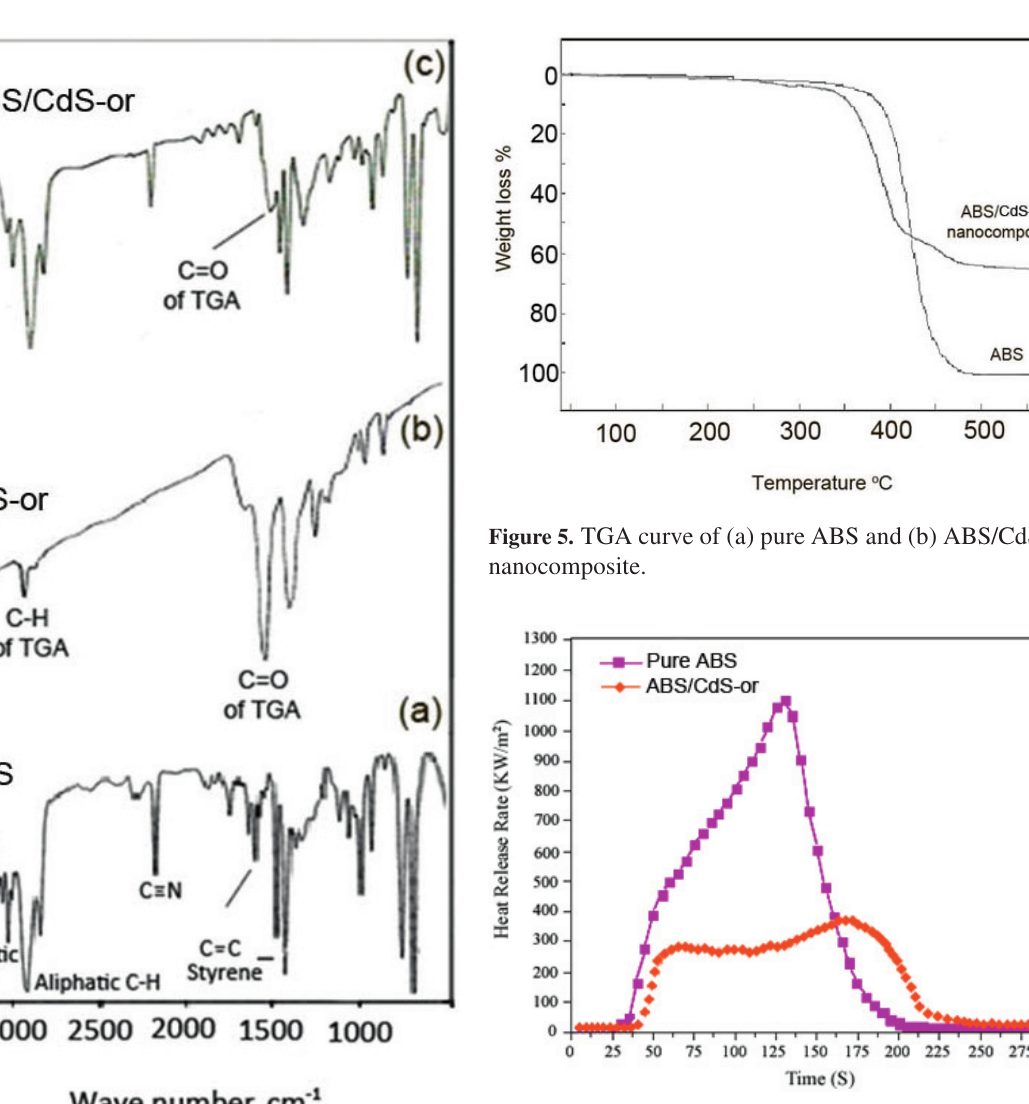
Figure 4. FT-IR spectrum of (a) pure ABS, (b) CdS-or flower like and (c) ABS/CdS-or nanocomposite.